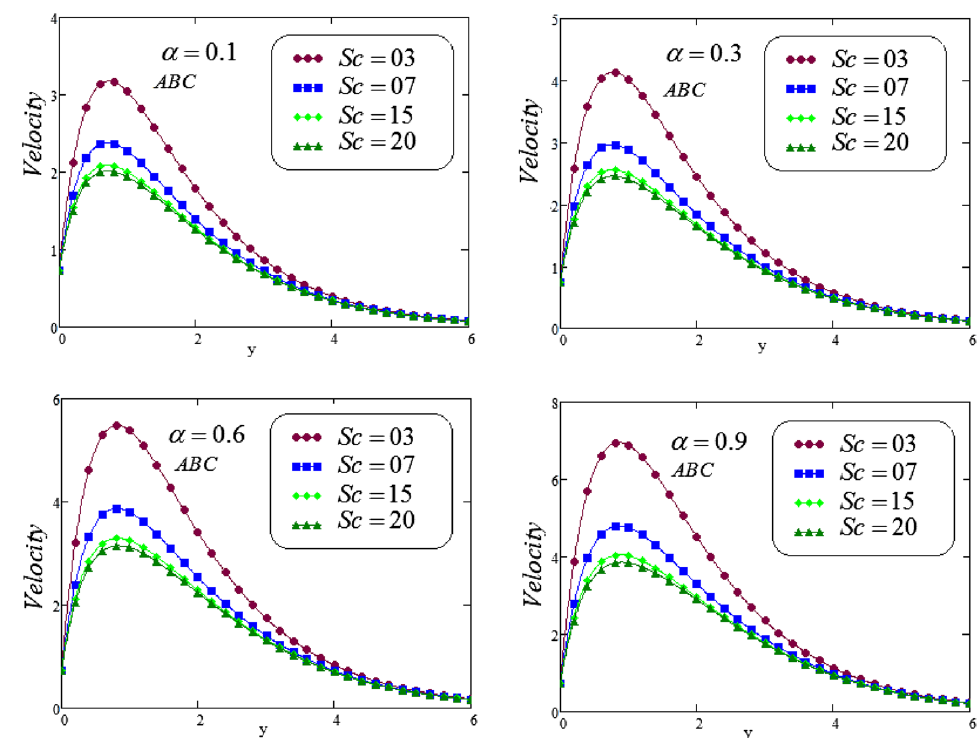
Figure 13. Representation of second grade fluid velocity via ABC for distinct values of Sc